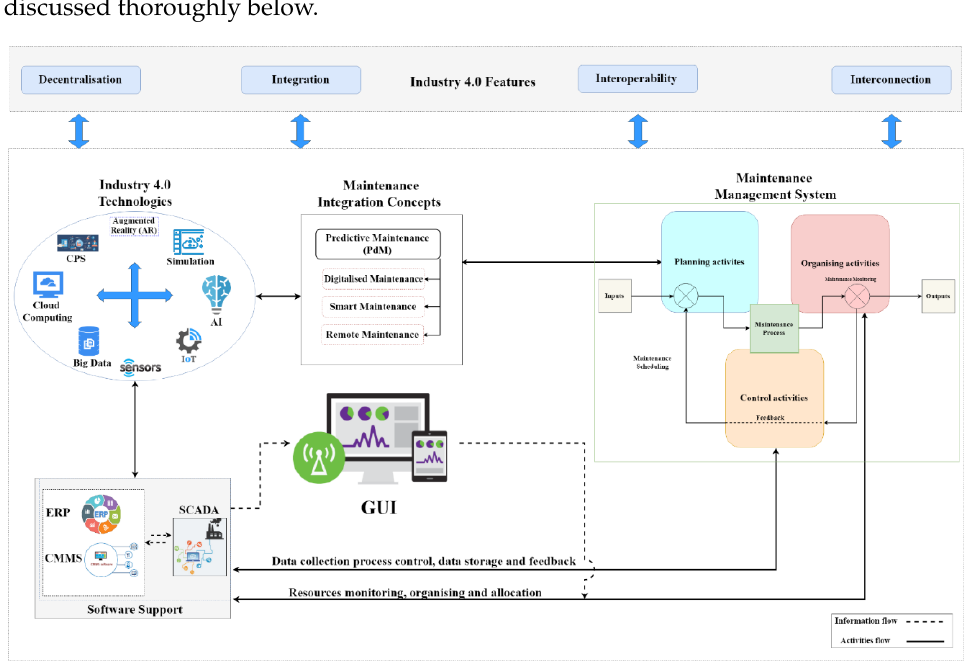
Figure 5. Summary of Integration of Industry 4.0 features and technologies and the adopted maintenance management system. Source: Authors’ elaboration.